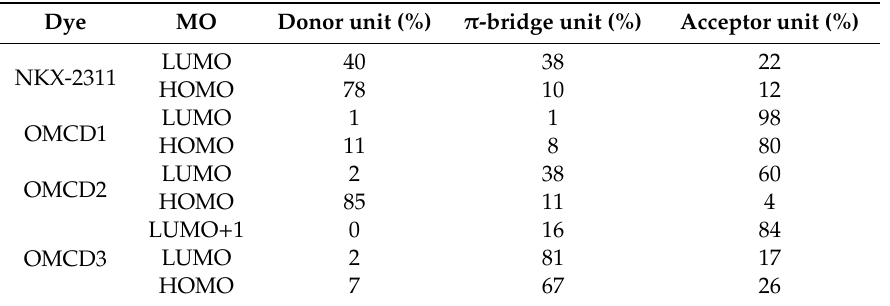
Figure 3. Energy diagram showing the ground state (blue) and the excited state (red) energies calculated in solution by DFT and time-dependent (TD)-DFT (B3LYP / DZVP) methods for the TiO 2 , NKX-2311, OMCD1, OMCD2, OMCD3 molecules and the redox level of the I 3 − / I − . The values represent the lowest singlet-to-singlet transition, ∆ E 0-0 , in eV. Table 2. Contributions of the donor, π -bridge and acceptor groups to the electron density of the main molecular orbitals of de dyes, calculated at the DFT / B3LYP / DZVP level. For the oligomethine cyanine dyes the various units consist of the carboxyl anchor and the indolinium group, for the acceptor, the benzoindolinium group for the bridge and the various terminations for the donor.